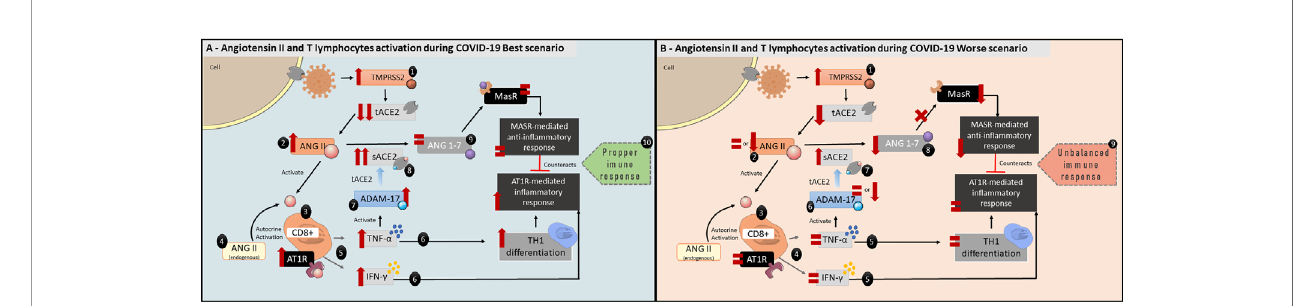
FIGURE 3 | Angiotensin II and T lymphocytes activation during COVID-19 best scenario. (A) 1: Reduction in tACE2 following SARS-CoV-2 infection. 2: ANG II will increase and 3: act as a co-stimulatory molecule in T lymphocytes activation acting via AT1R, which are expressed in CD8+ cells. 4: ANG II is also expressed by T lymphocytes, enhancing AT1R activation in an autocrine and intracrine manner. 5:AT1R activation stimulates CD8+ cells to produce both TNF- a and IFN- g . 6: TNF- a will increase TH1 differentiation, and, together with IFN- g , activate the in fl ammatory response. 7: TNF- a will also activate ADAM-17 activity leading to 8: increase the biologically active sACE2 and, 9: maintaining ANG 1-7 levels. 10: ANG 1-7, which has anti-in fl ammatory characteristics, will counterbalance TNF- a and IFN- g direct effects via MasR pathway. Taken together, these alterations would lead to a proper immune response to SARS-CoV-2 infection. (B) Angiotensin II and